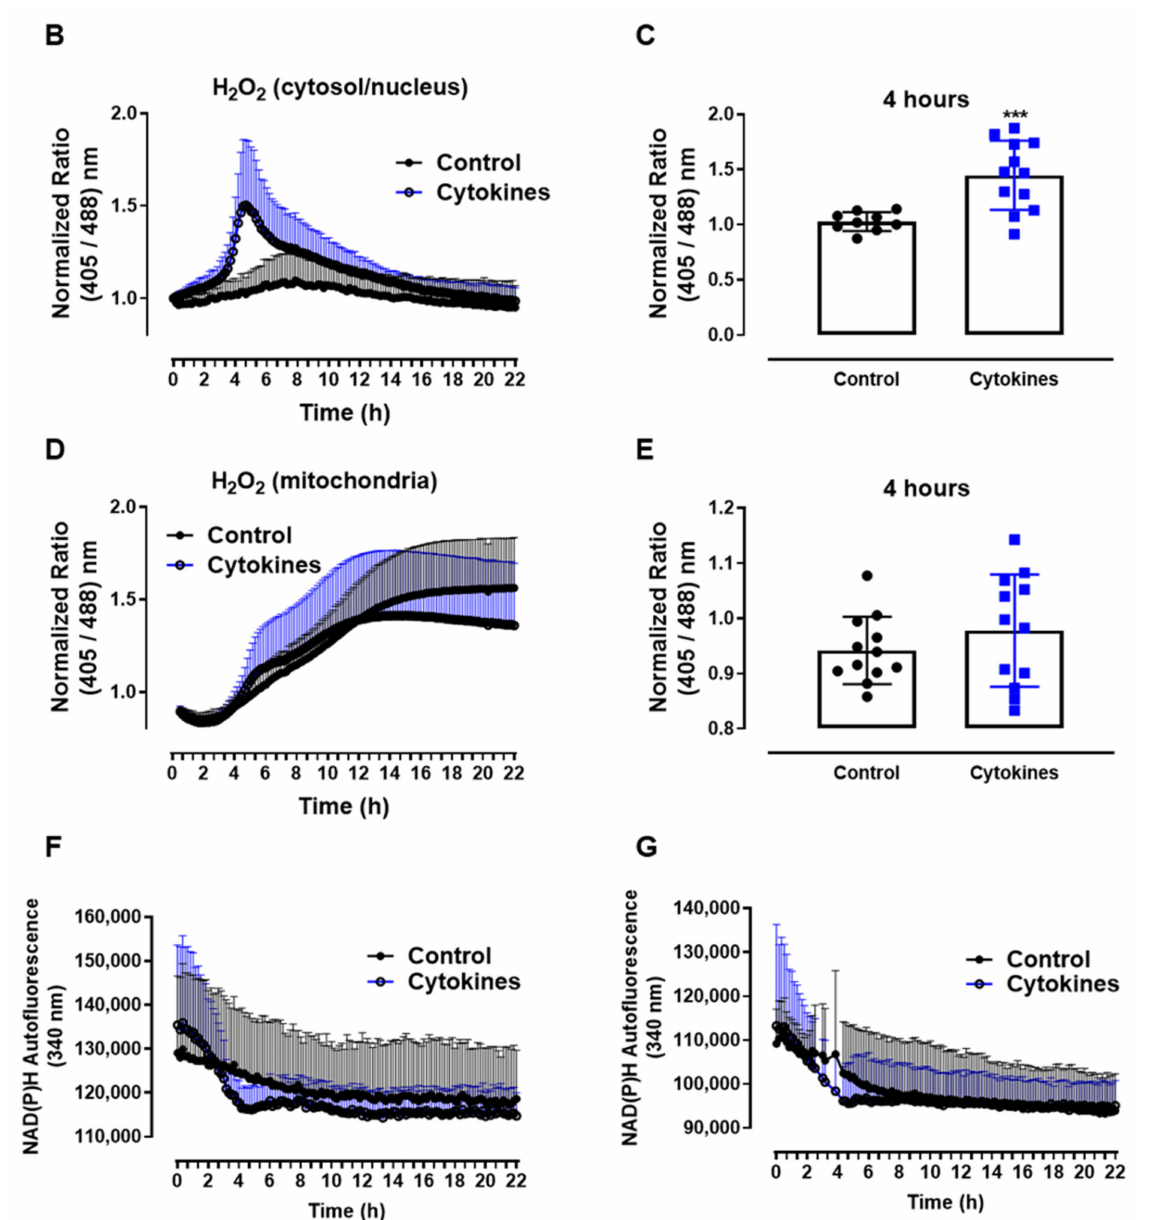
Figure 1. ROS production in pancreatic islets exposed to proinflammatory cytokines. ( A ) Superoxide production from wild- type islets in the absence (Ctrl) or presence of proinflammatory cytokines after different periods of exposure, as indicated. The fluorescence intensity was analyzed by flow cytometry using DHE dye. The results are expressed as the mean ± SD of 3–6 independent experiments. A.U.: arbitrary units. ( B ) Dynamic levels of the cytosolic/nuclear H 2 O 2 of islets from roGFP2- Orp1 mice incubated with proinflammatory cytokines. ( C ) Peak of the normalized ratio of ( B ) at 4 h. ( D ) Dynamic levels of mitochondrial H 2 O 2 of the islets from Mt-roGFP2-Orp1 mice incubated with proinflammatory cytokines. ( E ) Peak of the normalized ratio of ( D ) at 4 h. The fluorescence intensity was captured every 10 min for 22 h. The results are presented as the normalized ratio (405/488 nm) and mean ± SD of triplicates from 3 to 4 independent experiments. ( F , G ) Dynamic levels of NAD(P)H of the islets from roGFP2-Orp1 ( F ) and Mt-roGFP2-Orp1 ( G ) mice incubated with proinflammatory cytokines. The results are presented as the mean ± SD of triplicates from 3 to 4 independent experiments. * p < 0.05 and *** p < 0.001 when compared to the control using One-Way ANOVA + Dunnett’s ( A ) or a Student’s t -test ( C ). Proinflammatory cytokines mix: 10-U/mL IL-1 β + 100-U/mL TNF + 14-U/mL IFN- γ